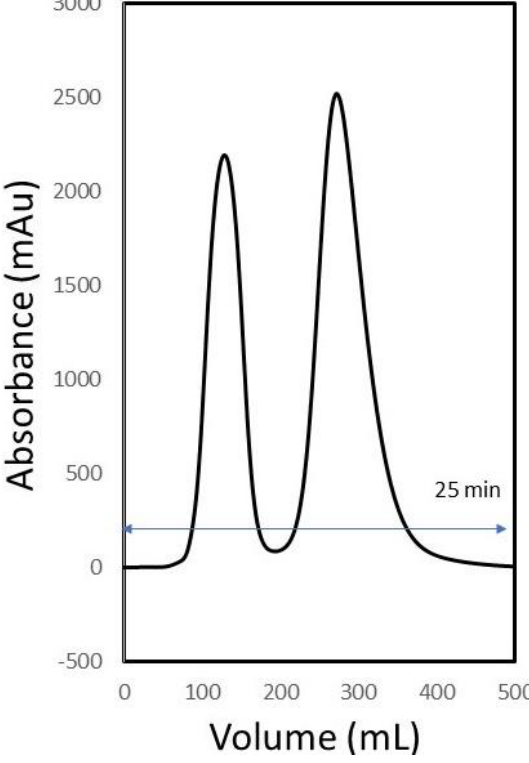
Figure 10. Chromatogram obtained during BSA (10 mg/mL) and lysozyme (4 mg/mL) separation using the 200 mL z 2 cuboid SEC device by loading 40 mL of feed sample at a 20 mL/min flow rate (medium: Sephacryl S-200 HR; mobile phase: phosphate-buffered saline (pH 7.4)).